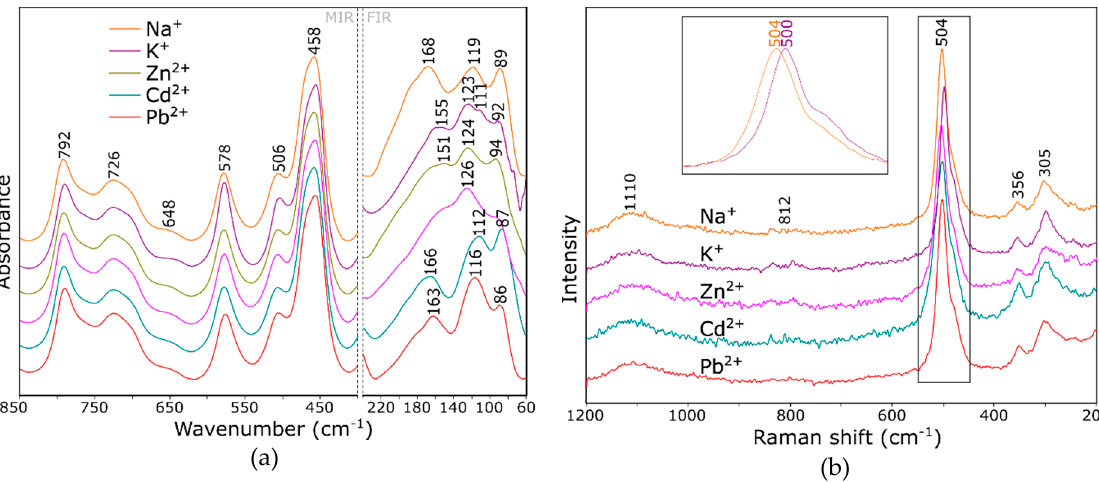
Figure 5. Fourier-transform infrared (FTIR) ( a ) and Raman ( b ) spectra of zeolite Y, with zeolite spectra with various cation guests.